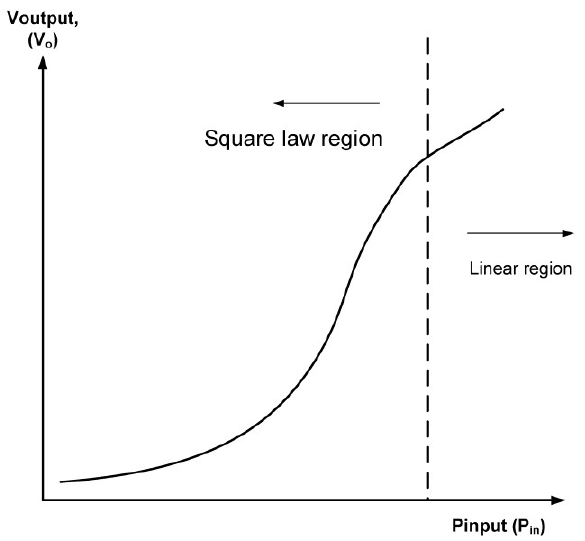
Figure 6 . Output voltage vs. input power